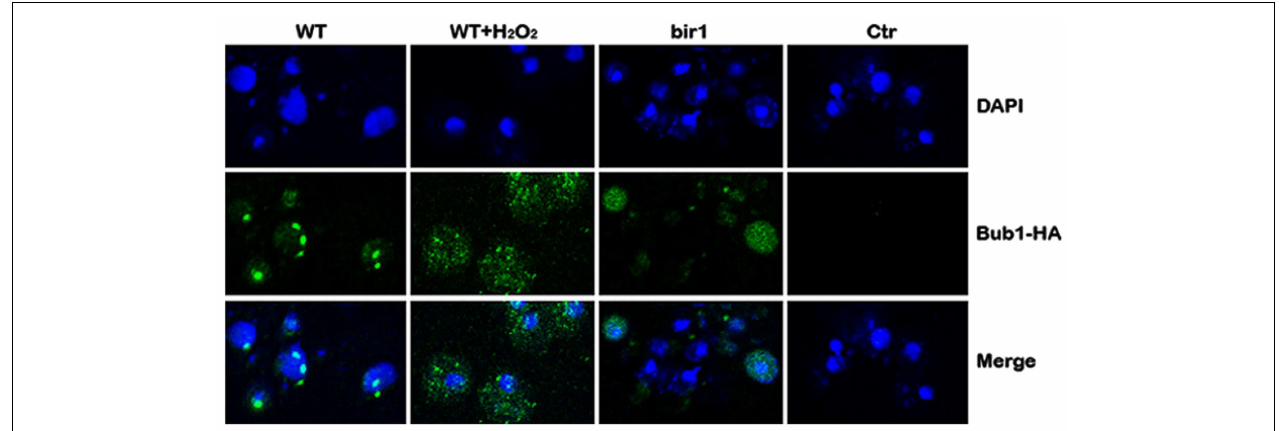
(YPDCu, 24˚C); Cells were then transferred to inducing medium (YPG, 37˚C) for 1˚h (bir1). Bub1 localization was assayed by immunostaining and confocal microscopy. Control (Ctr) was conducted by replacing primary antibody (anti-HA) with buffer.